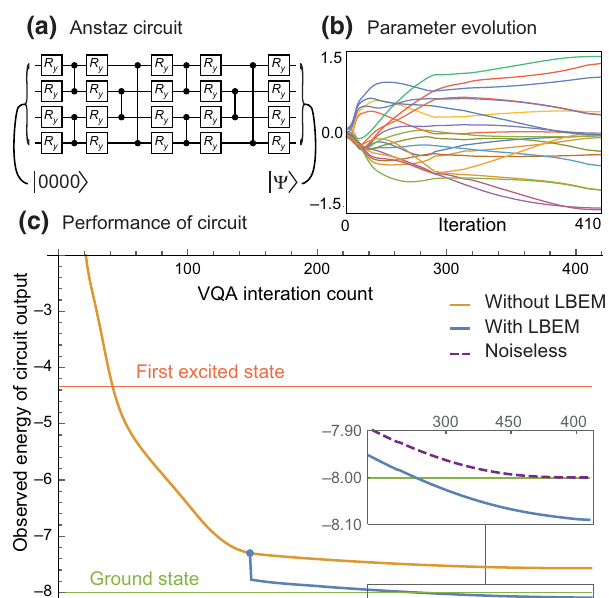
FIG. 6. Performance of the learning-based mitigation proto- col in the context of a QVA. The ansatz circuit (a) includes 20 parameterized gates R y (θ i ) = exp ( − i θ i / 2 σ y ) and the parameters are adjusted with the goal of finding the ground state of a certain frustrated spin system. The processor is a virtual noisy four-qubit device, emulated by the QuEST. When the QVA employs simple extrapolation-based mitigation [(c), orange line], the final energy is above the ideal target by 5.6%. Instead using learning-based error mitigation, the final energy is below the target by only 0.7%. The parameter evolution for the latter case is shown in panel (b). Further details of the two protocols are provided in the main